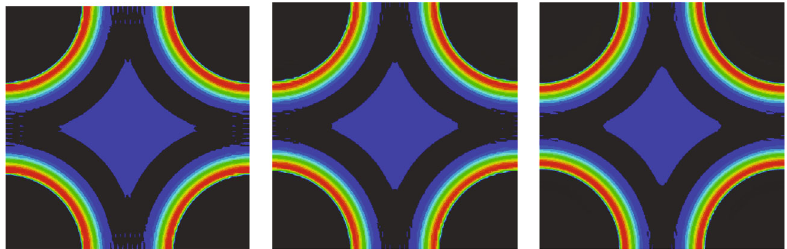
Figure 47: Contact stress cloud diagram of rock slab under di ff erent proppant heights (3 mm, 5mm, and 8mm).